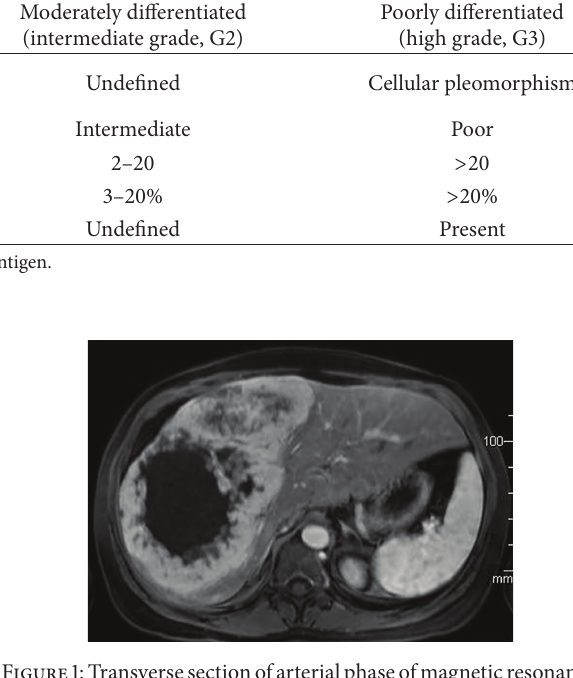
Figure1:Transversesectionofarterialphaseofmagneticresonance: large right liver lobe tumor exhibiting early peripheral enhancement and a central cystic